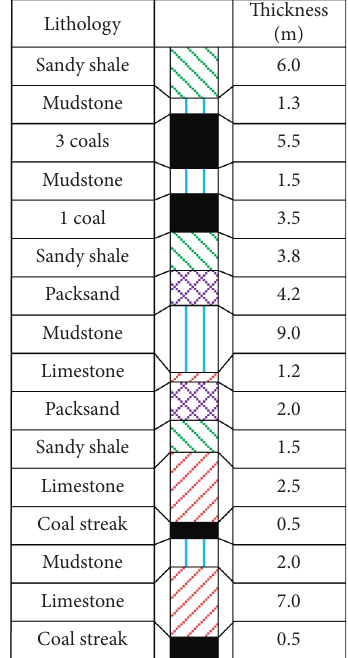
Figure 2: Lithology histogram of the 11123 working